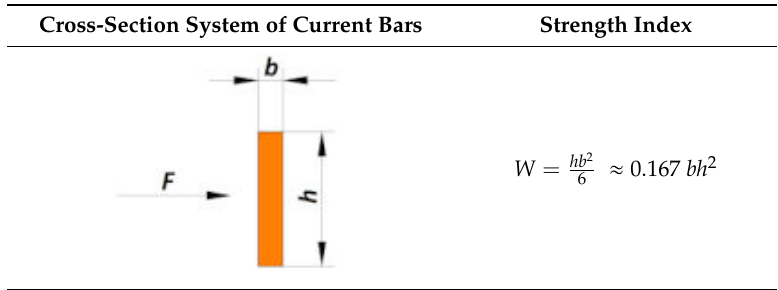
Table 3. Graphs for determining the dynamic bending stress coe ffi